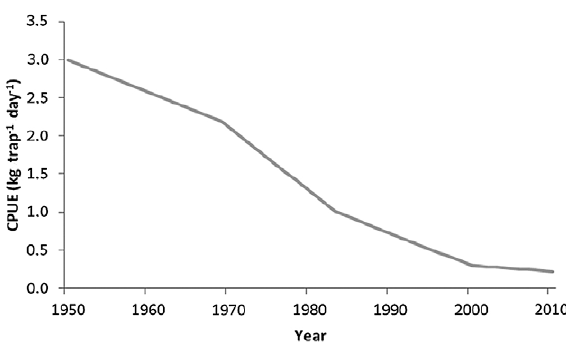
Fig. 4. – Catch per unit effort (CPUE) in kg trap –1 day –1 of the de- mersal artisanal trap fishery in the Canary Islands, 1950-2010.